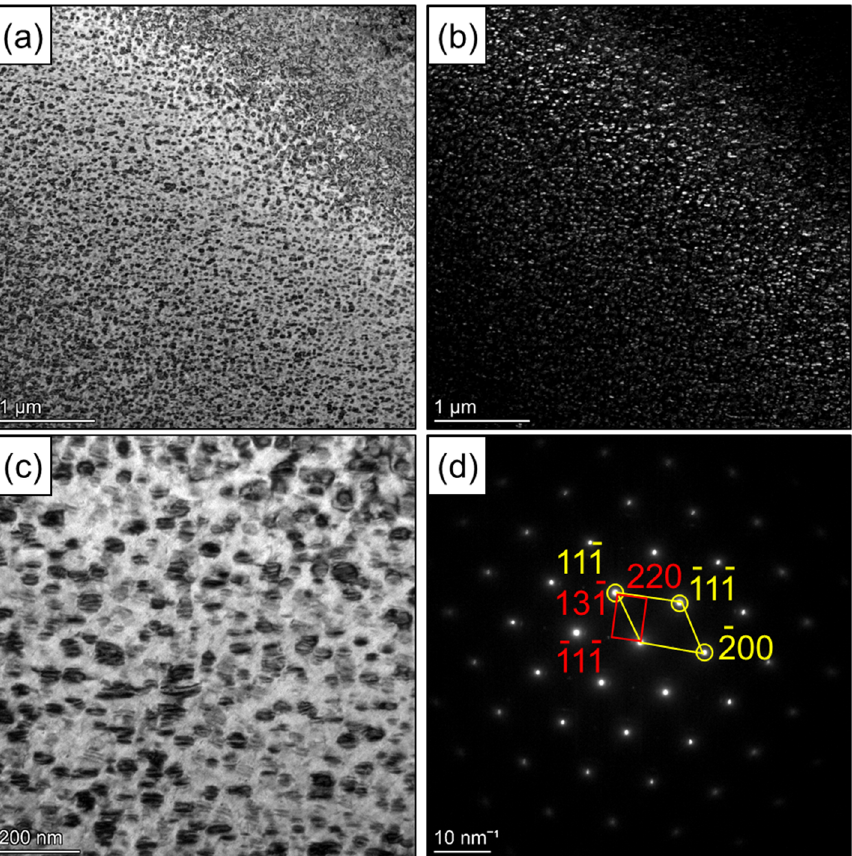
Figure 5. Bright-field and dark-field TEM images of the 5# sample: ( a ) low magnified bright-field image, ( b ) dark-field image, ( c ) high low magnified bright-field image, ( d ) SAD image.